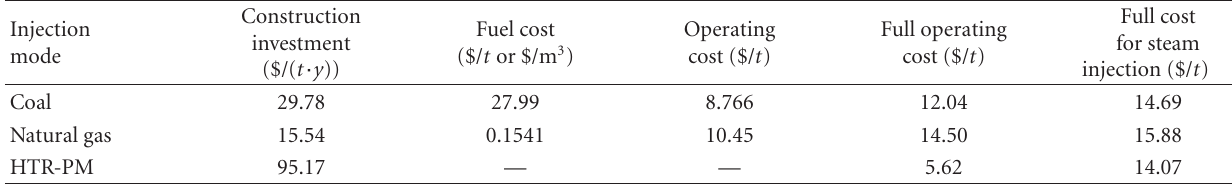
Table 3: Costs of steam injection by boiler and